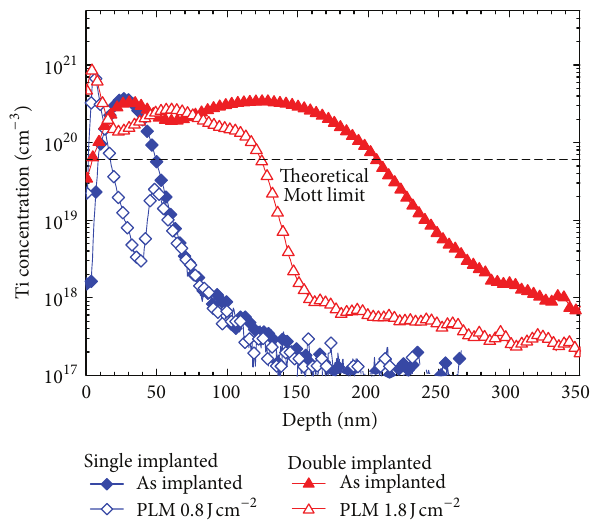
Figure 2: ToF-SIMS Ti concentration depth profile for the single implanted samples and for the double implanted samples before and after PLM. The single implanted set of samples were PLM processed at 0.8 Jcm −2 and the double implanted were PLM processed at 1.8 Jcm −2